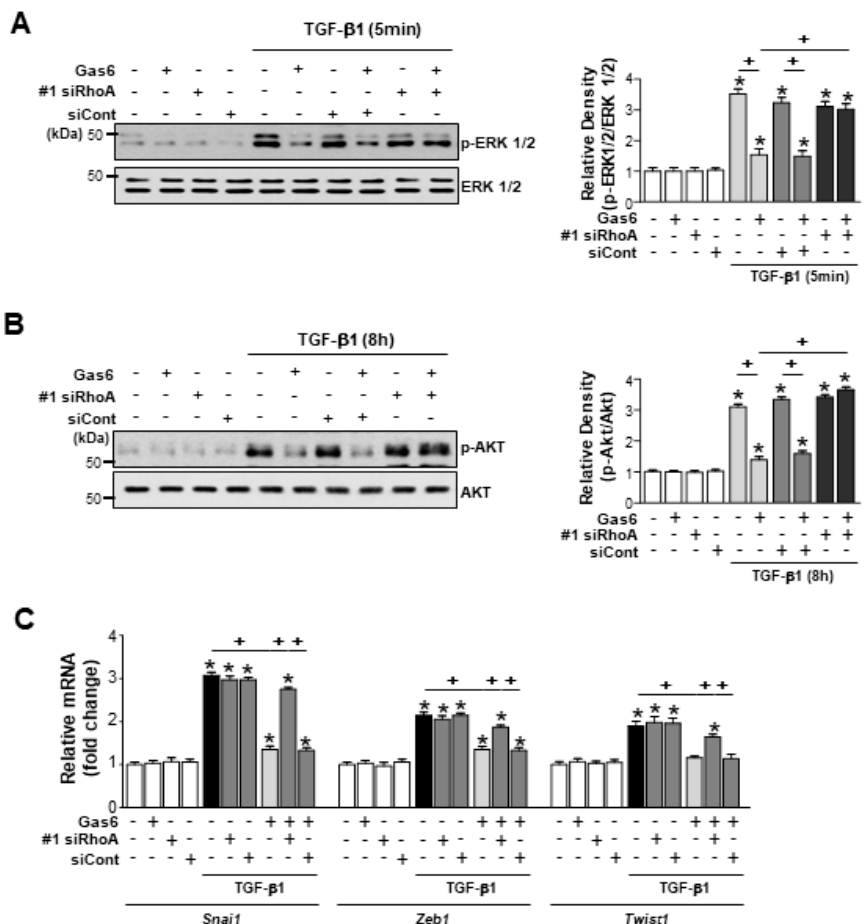
Figure 4. RhoA is involved in the Gas6-induced inhibition of non-Smad signaling pathways and EMT transcription factors in LA-4 cells. LA-4 cells were transfected with RhoA -specific or control siRNAs (#1 siRhoA or siCont) for 24 h prior to treatment with 400 ng / mL Gas6 for 20 h and then stimulated with 10 ng / mL TGF- β 1 for the indicated times or 48 h. ( A , B ) Representative immunoblots of LA-4 cell lysates were performed with anti-total / phosphorylated extracellular signal-related kinase (ERK)1 / 2 antibodies in A and with anti-total / phosphorylated AKT (Ser473) antibodies in ( B ). ( C ) qPCR analysis of the mRNA levels of EMT-regulating transcription factors. Values represent the mean ± SEM of three independent experiments. * p < 0.05; compared with control; + p < 0.05, as indicated. Results are representative of three independent experiments.